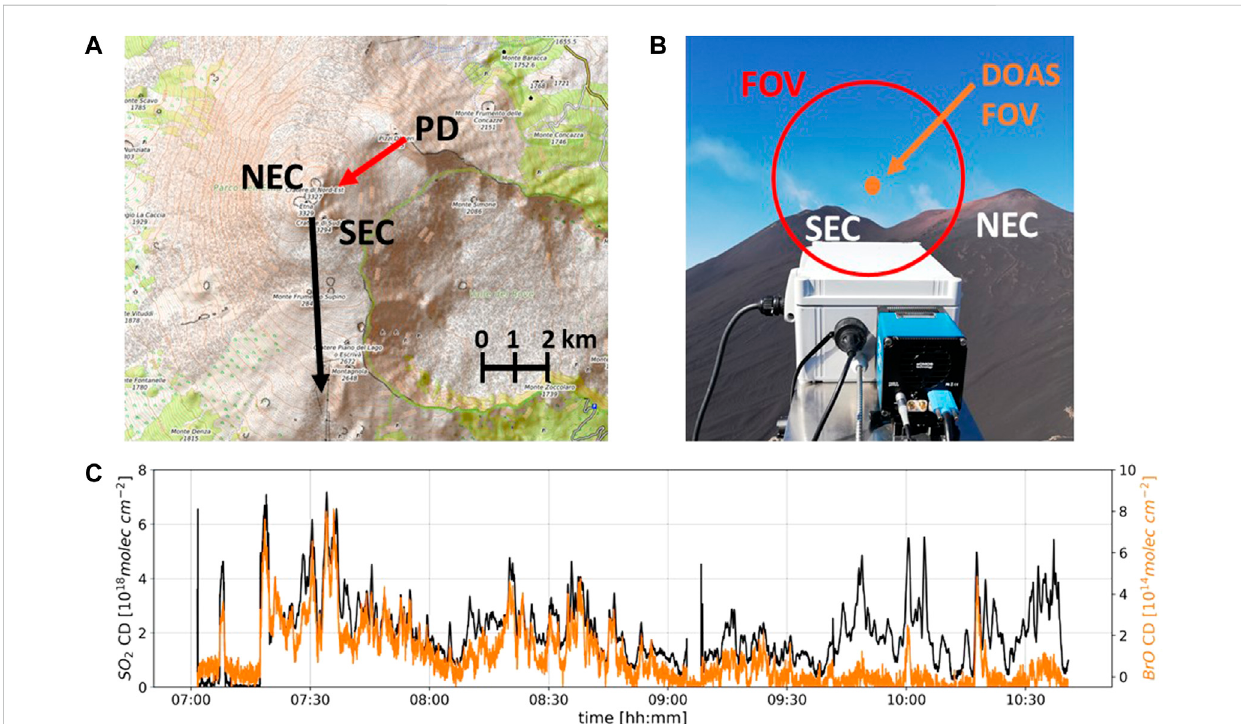
FIGURE 7 (A) Topographic map (OpenTopoMap, 2022) of the measurement location from 24th of July 2021, close to the Pizzi Deneri (PD) observatory, showing the viewing direction of the camera (205 ° SW, red arrow) and the plume direction (178 ° S, black arrow). Additionally, the South Eastern crater (SEC) and the North Eastern crater (NEC) of Mt Etna are marked. The measurement location has an approximate distance of 2.5 km to the crater area. (B) ImageoftheBrOcamerawith SECandNECinthebackground.TheredcirclemarkstheFOV ofthecamera. Theplumeisfaintly visiblebetweenthe two craters. The DOAS FOV is marked with an orange circle and it points directly into the plume. (C) Time series of the DOAS measurement (location marked with orange circle in panel B). The black line (left y -axis) shows the SO 2 CD and the orange line (right y -axis) the BrO CD between 07:00 — 10: 30 UTC. BrO and SO 2 CDs are correlated up to approximately 10:45 UTC, when the plume shows a stronger condensation and also clouds start to form inside the